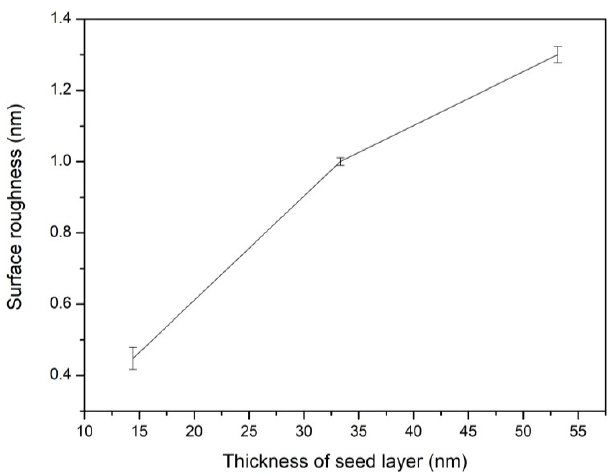
Figure 6. Surface roughness of seed layer measured with corresponding seed layer thickness.